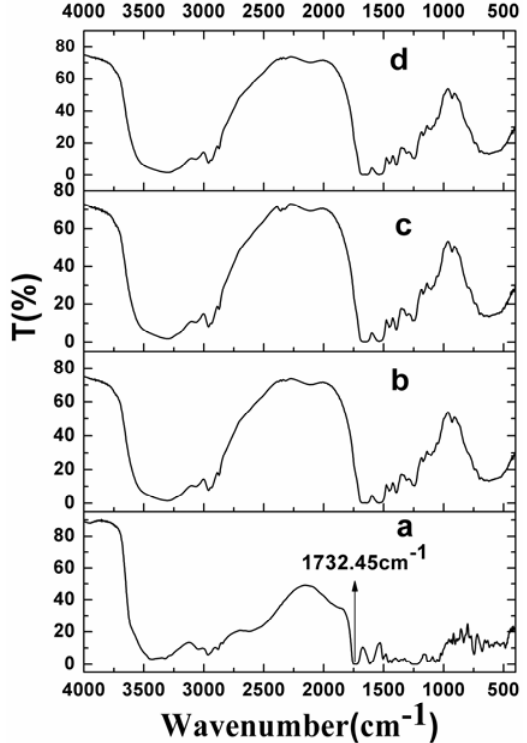
4. Fourier transform infrared (FTIR) spectra of raw VLBT and VLBT-loaded nanoparticles. ( a ) Raw VLBT; ( b ) VLBT-BSANPs; ( c ) Fa-BSANPs-VLBT; ( d ) Fa-BSANPs-VLBT with